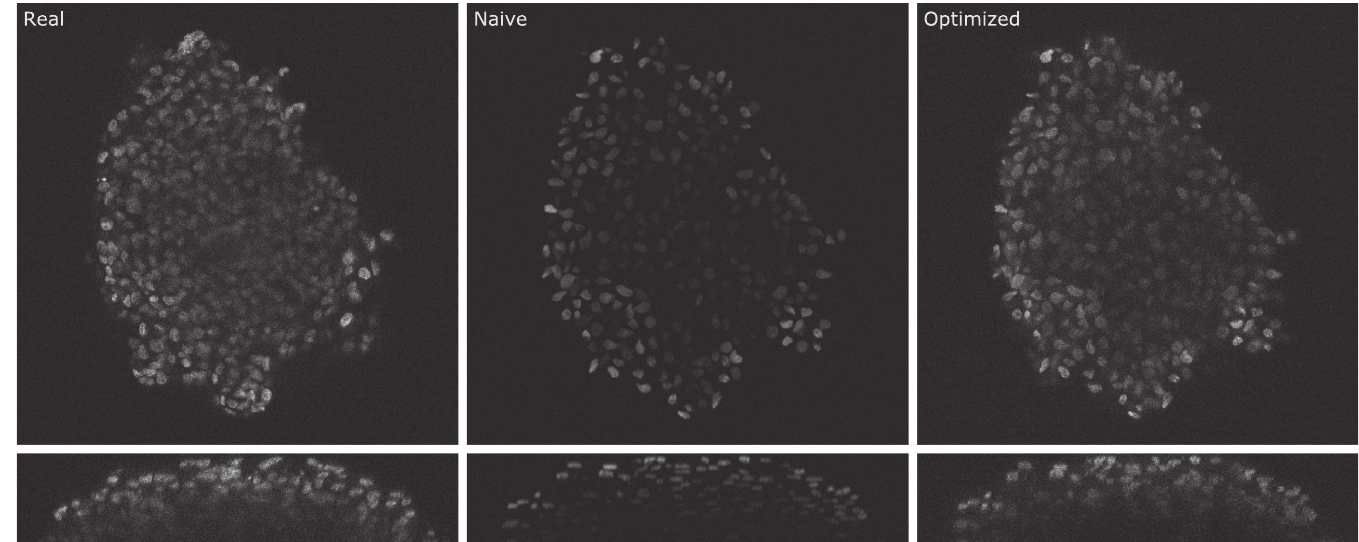
Fig 3. 2D slice of a real, naive and optimized image (top) and corresponding enlarged orthogonal views (bottom). While the shape of the cell culture roughly matches between real and synthetic data, the positions of the nuclei are different due to the generation process of the synthetic data. https://doi.org/10.1371/journal.pone.0283828.g003 0.9, and 0.86, respectively. The optimization of the naive data significantly improves the score with median values between 0.94 and 0.96 (exact Wilcoxon test: w = 46, p < .001, n = 156 j w = 195, p < .001, n = 157 j w = 0, p < .001, n = 48). The overall largest difference between real and naive data exists in the background region within the spheroid. In this region, the median values lie between 0.57 and 0.6. However, the optimization significantly improves the score for this region with lowest and highest median values of 0.84 and 0.93 (exact Wilcoxon test: w = 545, p < .001, n = 148 j w = 0, p < .001, n = 156 j w = 0, p < .001, n = 45). The larger scatter of the results, especially in the upper part of the image, is noticeable.